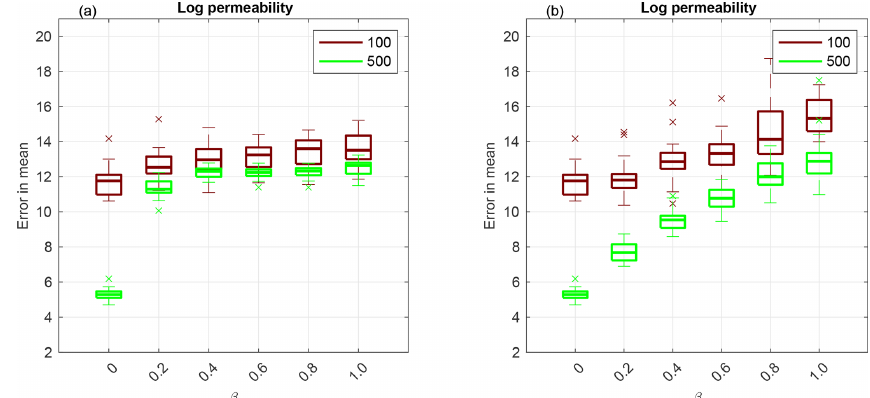
Figure 2. Application to F1 parameterisation: using Sinkhorn approximation (a) and optimal transport resampling (b) . Box plot over 20 independent simulations of the RMSE of mean log permeability. The horizontal axis is for the hybrid parameter, where β = 0 corresponds to the EKI and β = 1 to TET(S)PF. The ensemble size M = 100 is shown in red and M = 500 in green. The central mark is the median, the edges of the box are the 25th and 75th percentiles, whiskers extend to the most extreme data points and crosses are outliers.